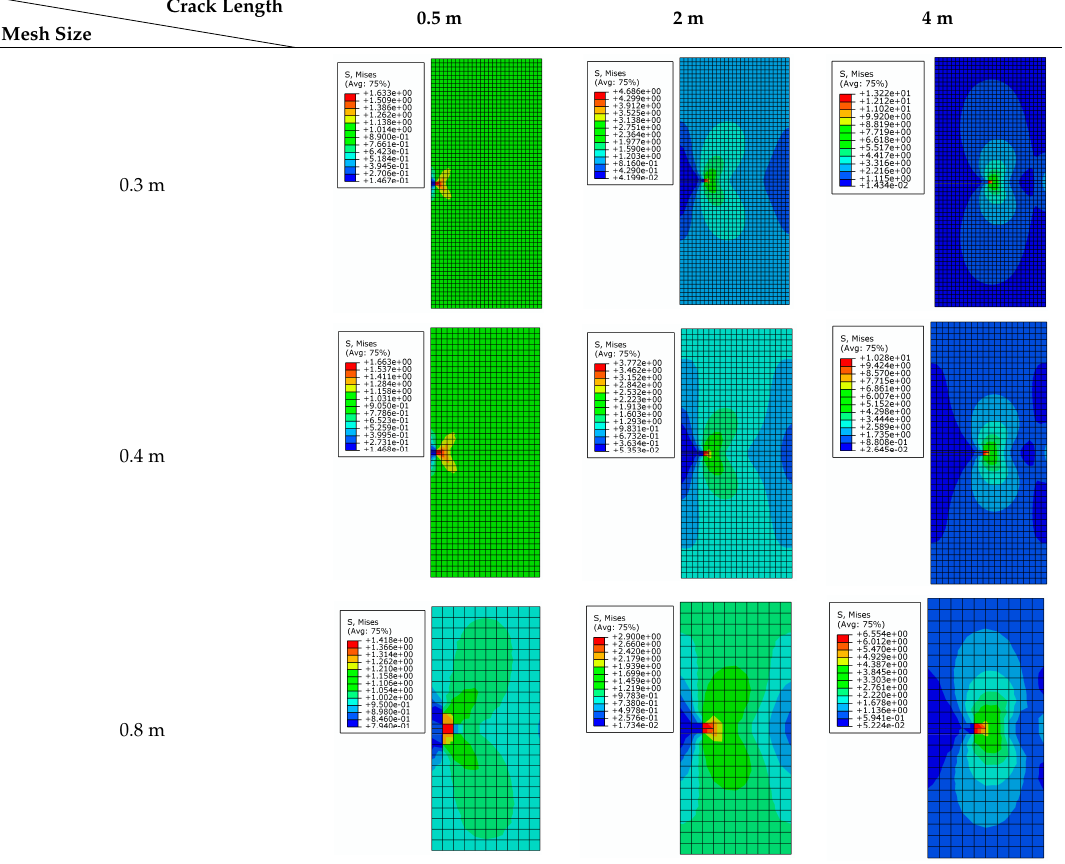
Table 3. The von Mises stress distribution of the rectangular plate for di ff erent crack lengths and mesh sizes.